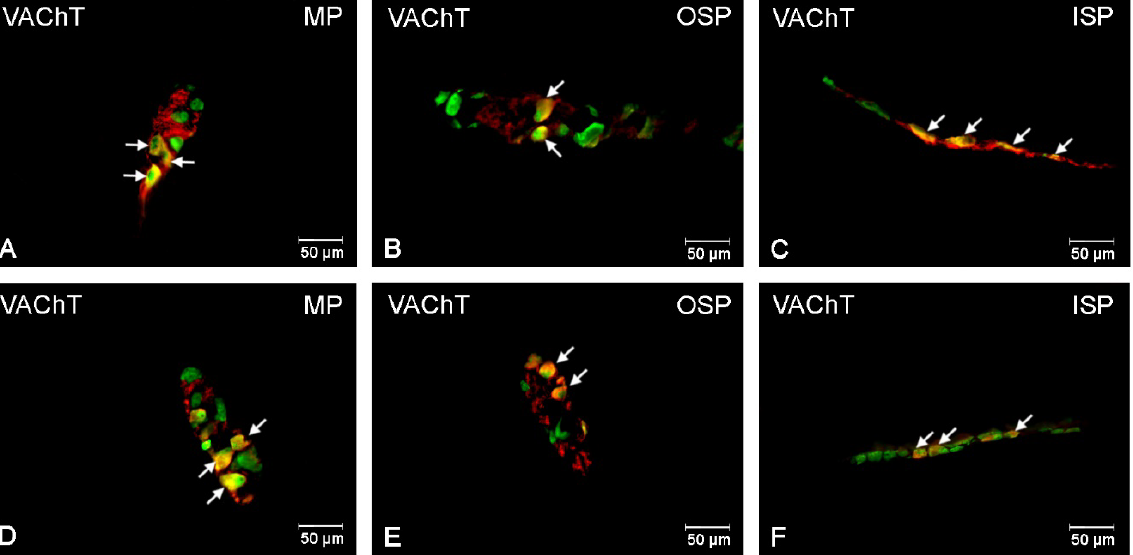
Figure 4. Fluorescence microscopy images showing protein gene product 9.5 (PGP 9.5) visible as green fluorescence that colocalizes with vesicular acetylcholine transporter (VAChT) visible as red fluorescence in the enteric neurons of the jejunum in pigs. The obtained images were created by computer superimposition of two channels (green and red). The photos show the enteric nervous system neurons of the pig’s jejunum under physiological conditions ( A , D , G ) and after administra- tion of low ( B , E , H ) and high ( C , F , I ) doses of acrylamide. Neurons immunoreactive for particular substances are advisable with arrows. MP—the myenteric plexus; OSP—the outer submucosal plexus; ISP—the inner submucosal plexus. 3.3. nNOS-Immunoreactive Neurons In the control group, a particularly abundant population of nNOS neurons 33.80 (±0.44) % was observed in the MP, while their number was significantly lower and amounted to 5.82 (±0.44) % in the OSP and to 7.46 (±0.69) % in the ISP [Figure 5]. In the low-dose acrylamide group, a decrease was observed in the nNOS neuron population in the ISP: 4.61 (±0.32) % [Figure 6F] and in the MP: 29.50 (±0.64) % [Figure 6D], while no changes were noted in the OSP. In contrast, in the experimental, high-dose acrylamide group, a statistically significant drop in the population of nNOS-positive neurons was ob- served in all the tested plexuses: in the MP to a value of 26.77 (±1.16) %, while in the sub- mucosal plexuses to 1.22 (±0.32) % in the OSP, and 1.77 (±0.45) % in the ISP, respectively [Figure 6 G–I].